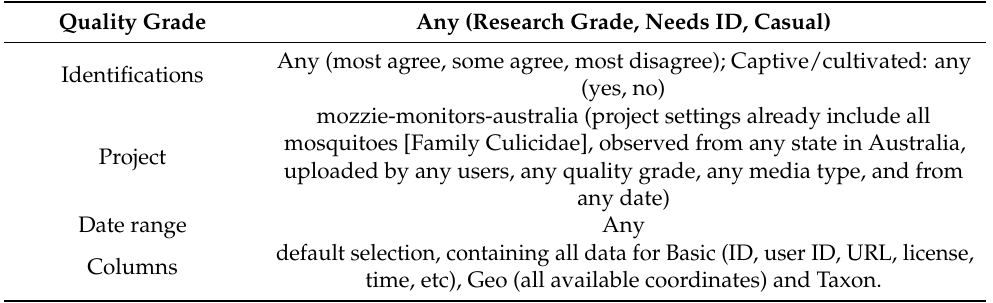
Table 1. Extraction filters selected to download mosquito observations from the Mozzie Monitors project on